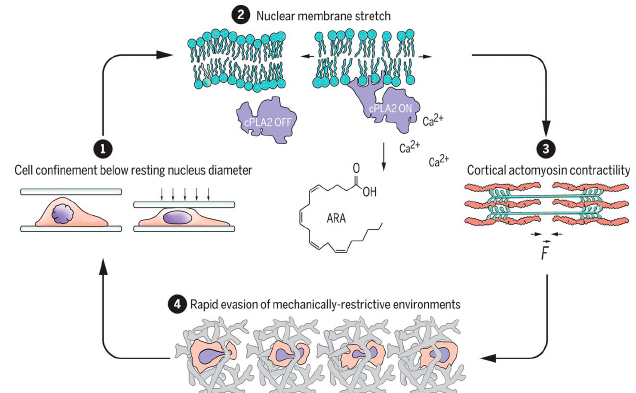
Figure 2. Schematic representation of nuclear deformation and stretching of the nuclear envelope after cell compression (1), which cause calcium release, phospholipase A 2 activation, and arachidonic acid production (2), for the regulation of actomyosin (3) and the increasing of cell migratory capacity through the 3D matrix (4). Reproduced from [89] under Science Copyright Clearance Center (CCC) license.